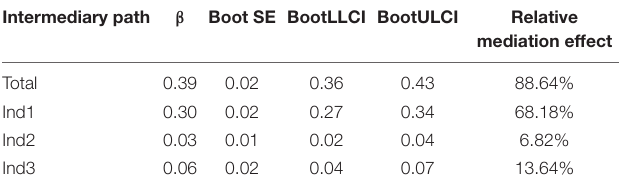
TABLE 3 | Mediating effects for